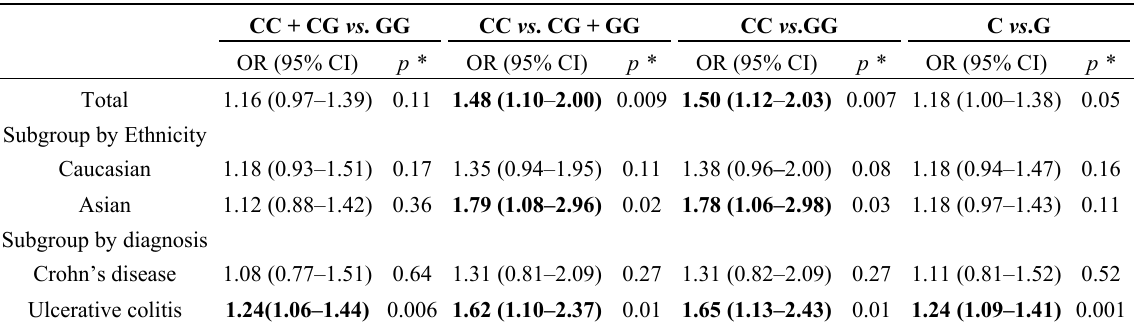
Table 3. Summary of different comparative results.